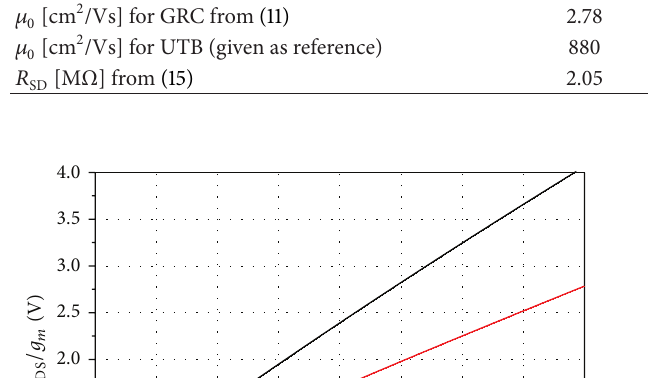
= 7 V (saturation) for both 300 K DS is appended accordingly. SD